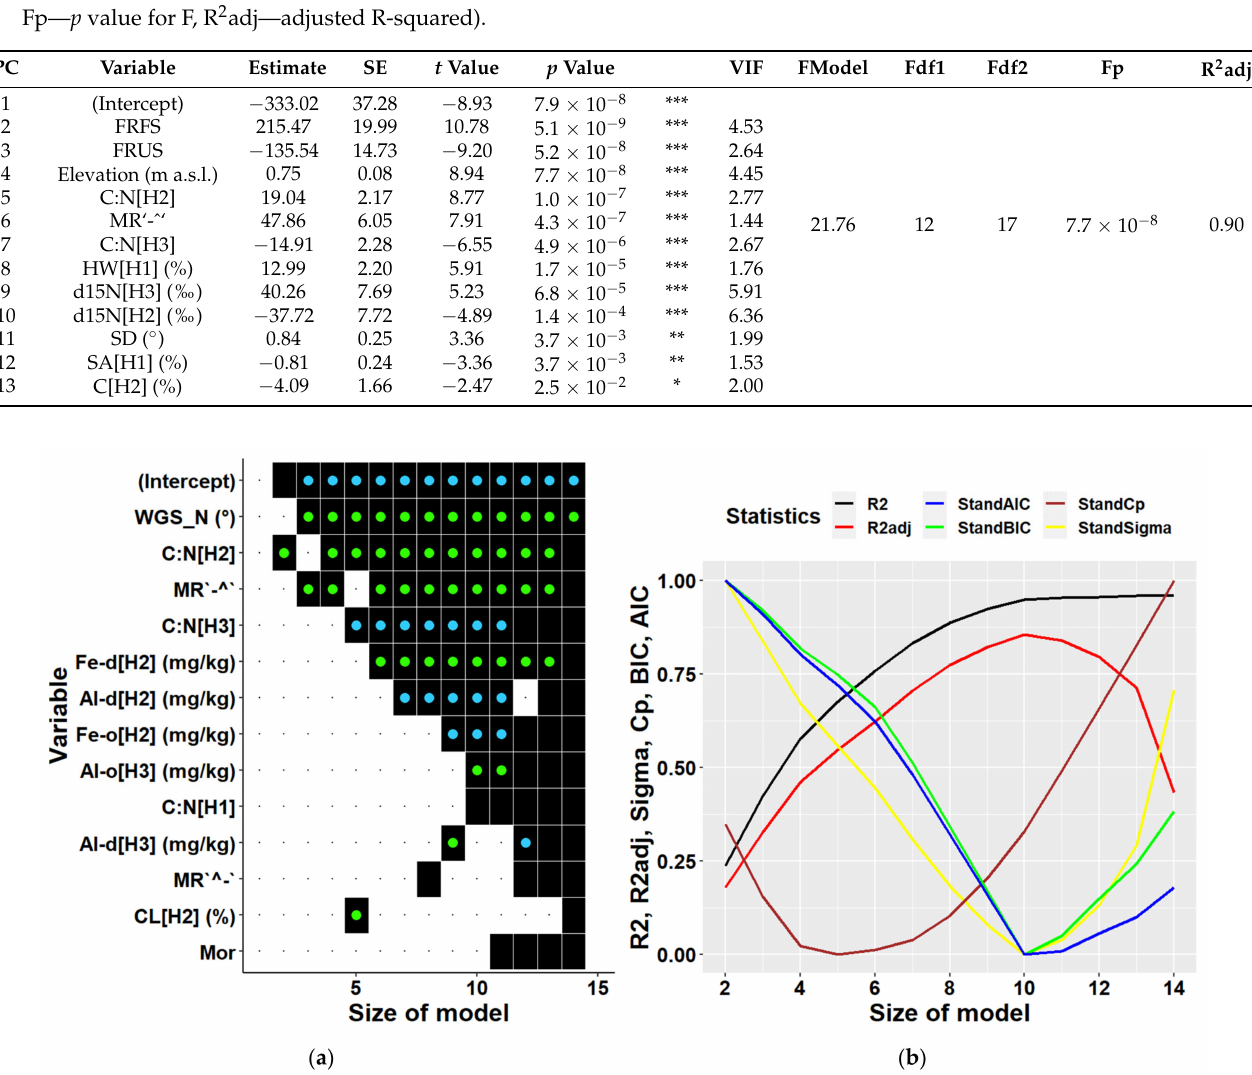
Table 3. Overview of variables included in the optimal multiple regression model (Biomass = f(Variable1, . . . , Variable13)) derived for Keta and Lama together and their statistical characteristics (H1—layer 0–10 cm, H2—layer 10–20 cm, H3—layer 20–30 cm, MR‘-ˆ‘—Micro relief—‘-ˆ‘, HW (%)—hygroscopic water, SA (%)—sand fraction, C:N—C:N ratio, C (%)—carbon content, d15N (‰)—ratio of stable nitrogen isotopes 15N:14N, Elevation (m a.s.l.)—elevation, FRUS—form of relief (peak, upper slope), FRFS—form of relief(foot of slope), SD ( ◦ )—slope downward, Estimate = regression coefficient for the respective variable, SE= standard error, t value— t -value of Student test of coefficient, p value—probability of t value and its